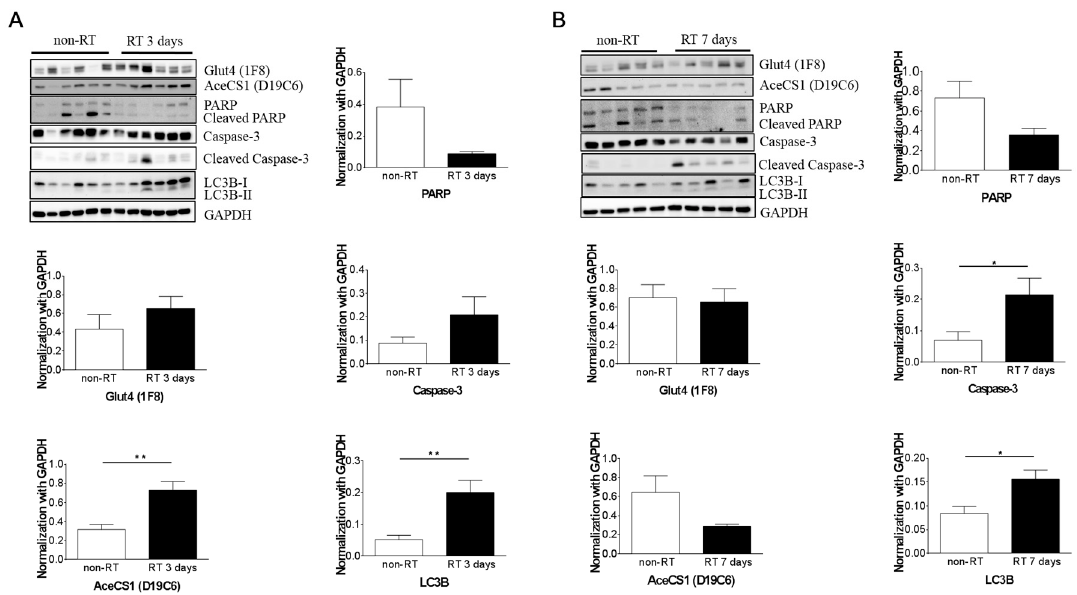
Figure 5. The Glut4, AceCS1, PARP, Caspase-3 and LC3 protein levels at Day 3 ( A ) and Day 7 ( B ) post-irradiation compared with the non-irradiated group. AceCS1 is overexpressed in RT 3 days tumors. No significant difference of Glut4 overexpression was found in the RT-tumors with Day 3 and Day 7 post-irradiation. * p < 0.05.